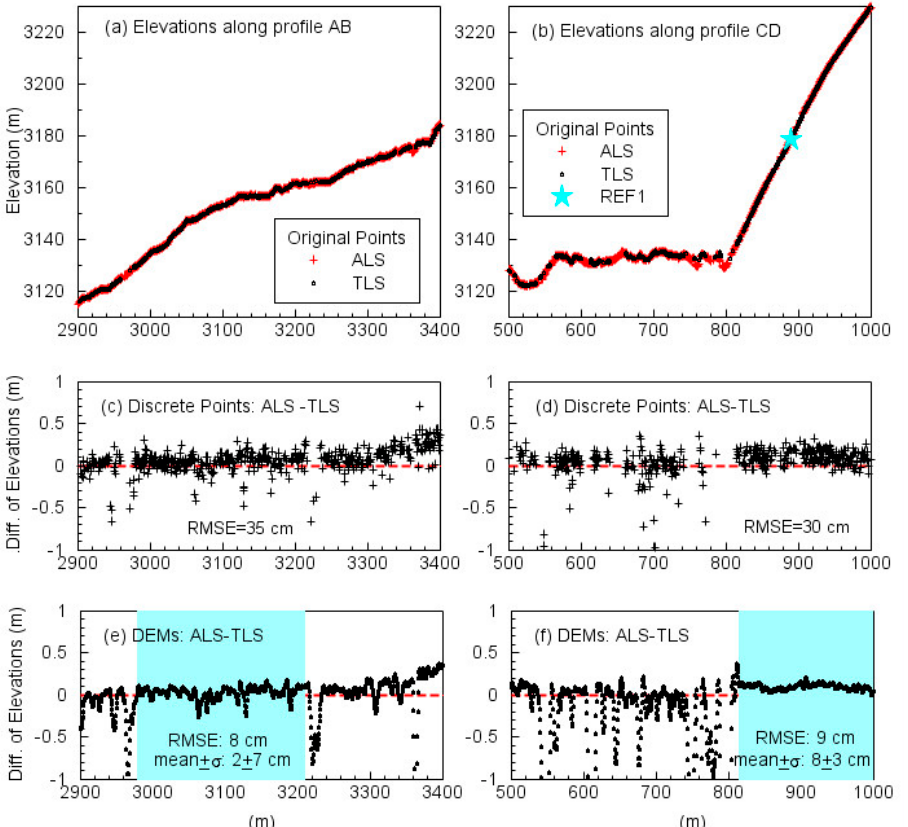
Figure 12. Comparisons of the elevation measurements from the ALS and TLS datasets depicted in Figure 11. The left column is the elevations along profile AB; the right column is the elevations along profile CD. The root mean square of errors (RMSE) and mean values marked in subplots ( e , f ) are calculated from the datasets within the shaded areas where both ALS and TLS datasets have continuous data coverage.